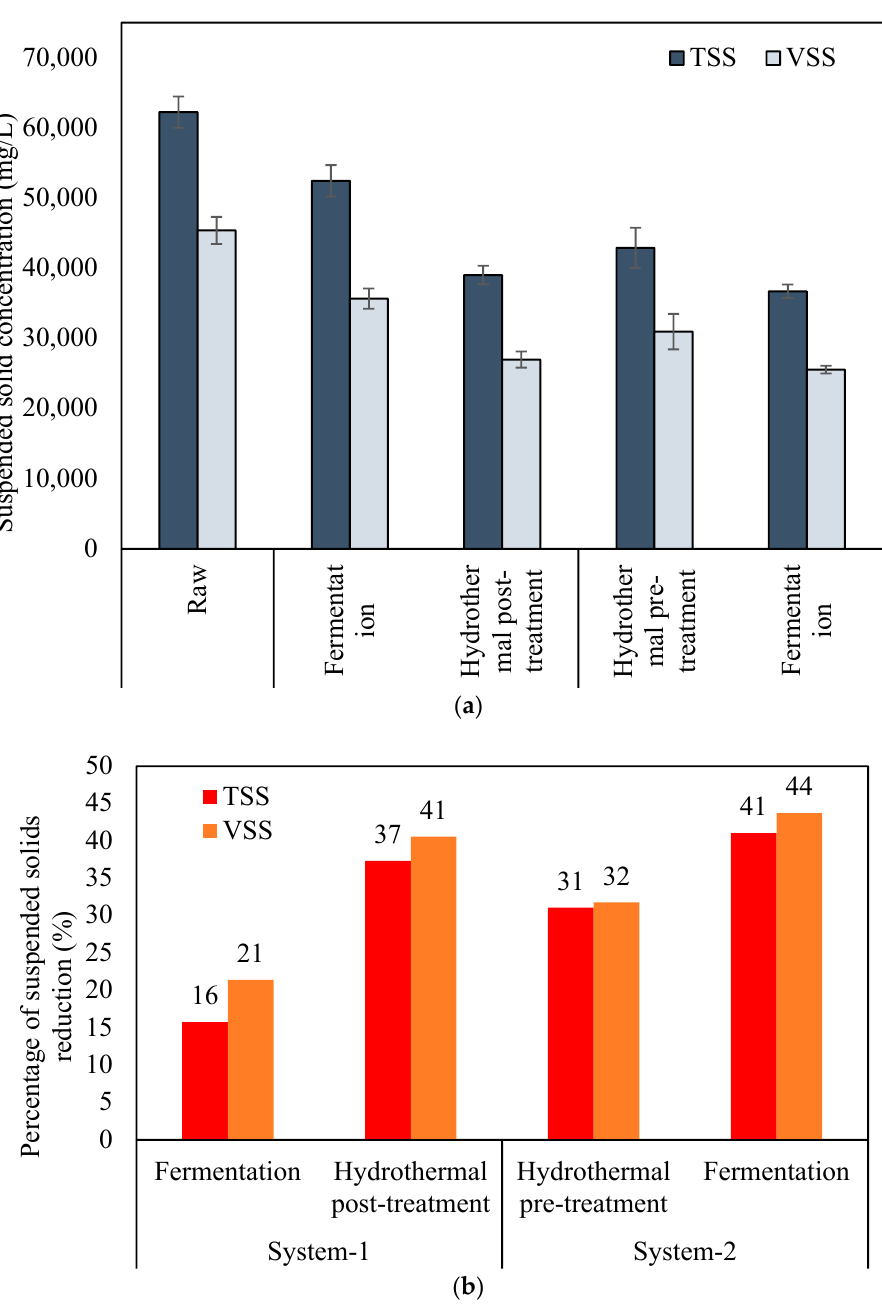
Figure 1. ( a ) The concentrations of suspended solids and ( b ) suspended solid reduction efficiency in raw, treated, and fermented SSO. (TSS: Total Suspended Solids, VSS: Volatile Suspended Solids)